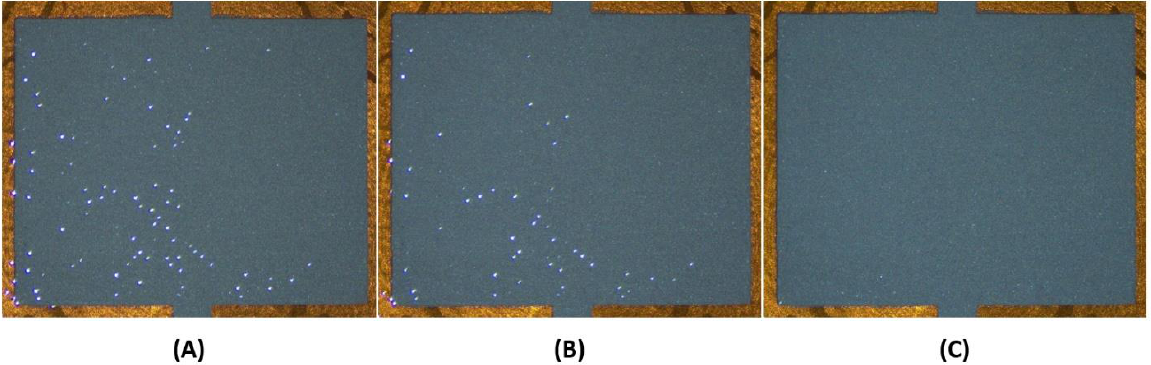
Figure 5. Photographic views of an insulating transparent UV layer printed on a silver-based layer: ( A ) 5 s after printing; ( B ) 10 s after printing; ( C ) 15 s after printing. These three views demonstrate the effect of the inks crosslinking, which leads to the disappearance of the pinholes over time.